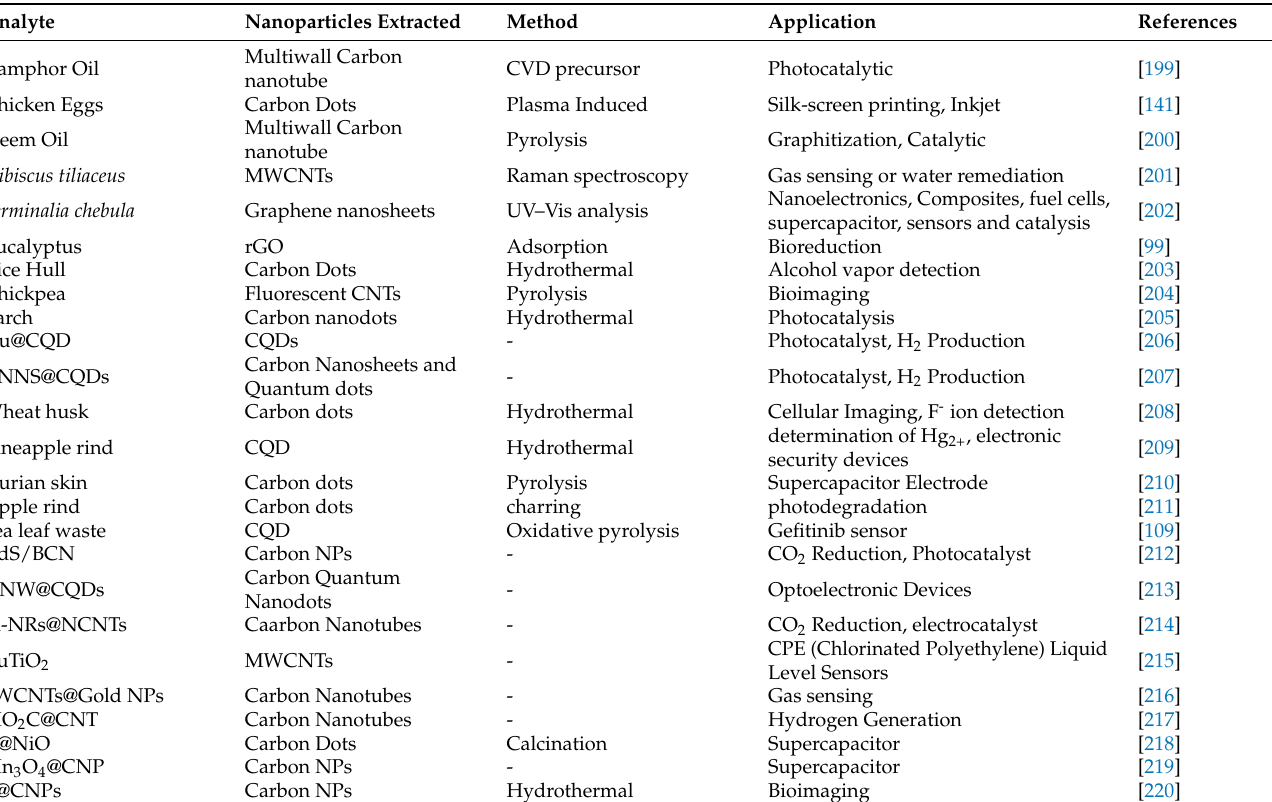
Table 1. Various carbon NMs employed for diverse environmental